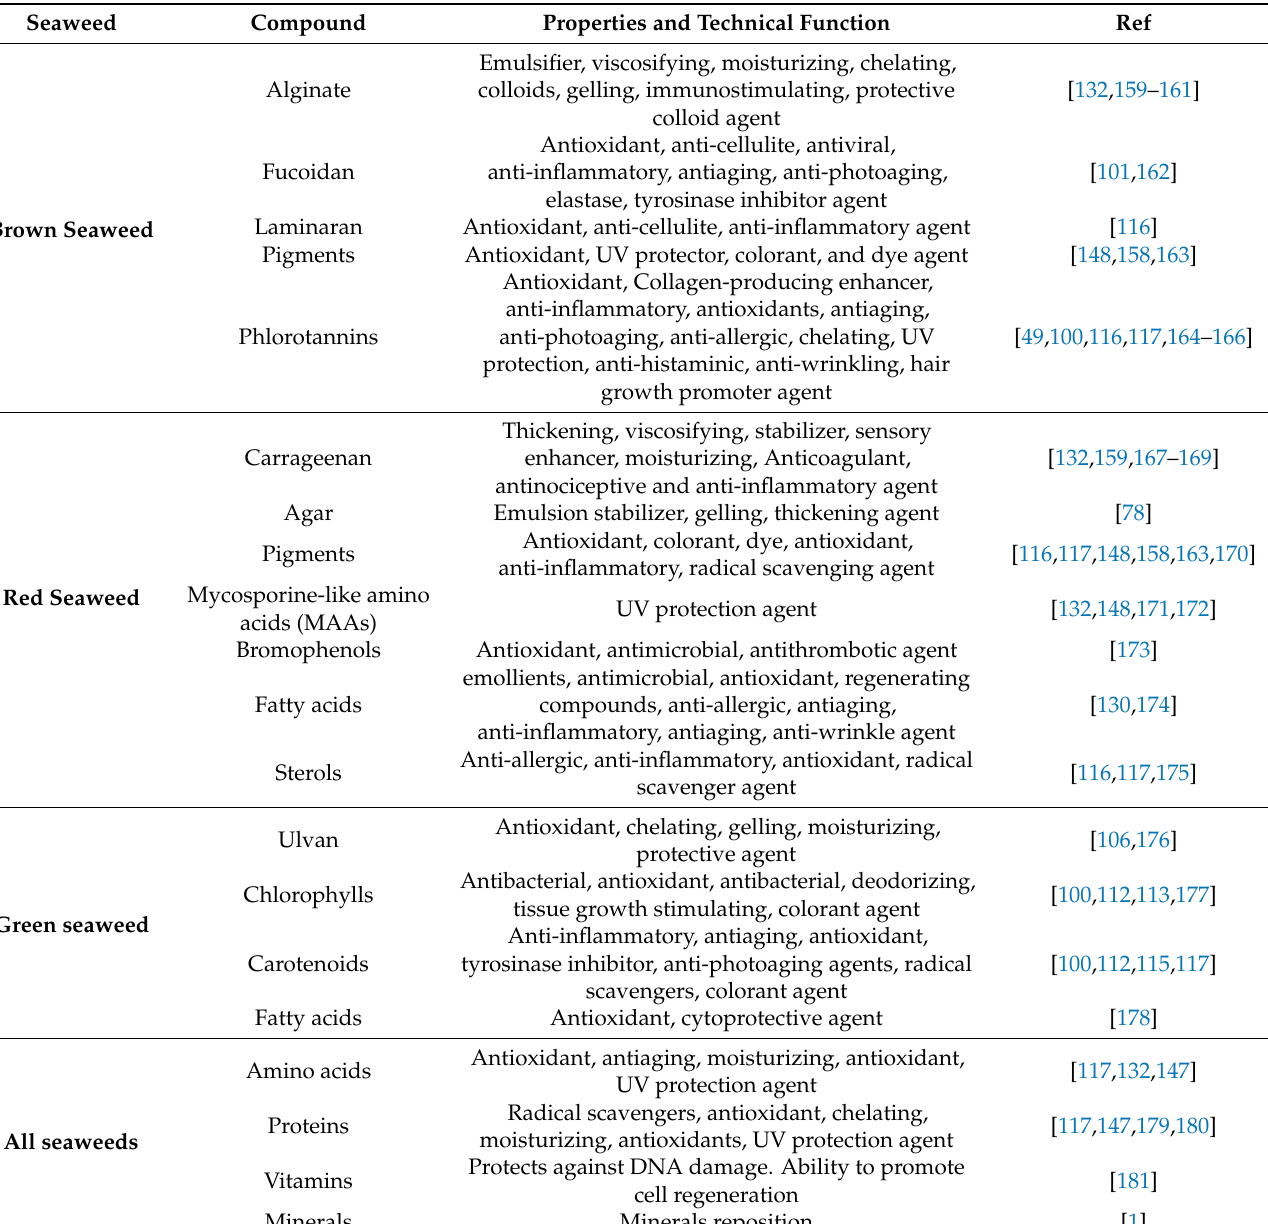
Table 2. Cosmetic properties and applications of seaweed